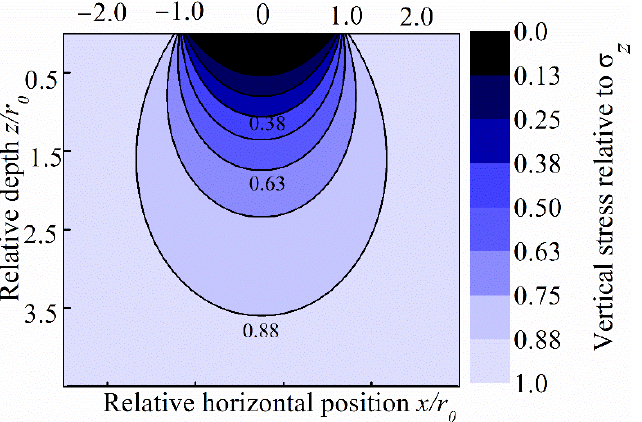
Figure 3. Distribution contours of the additional vertical stress relative to σ z near the damaged hole.